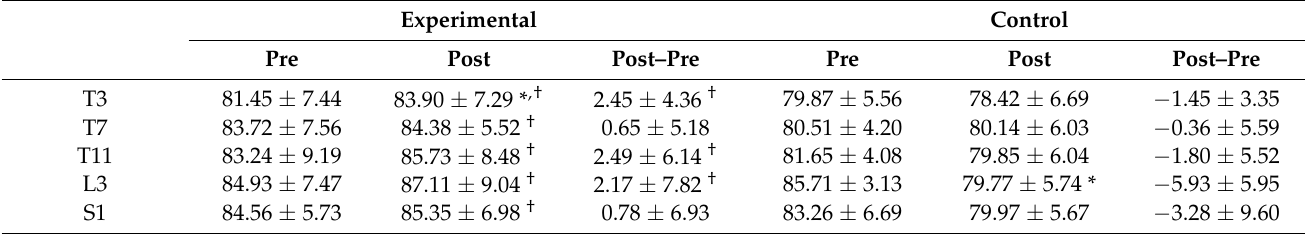
Table 4. Comparison of trunk angle (unit: ◦ ).